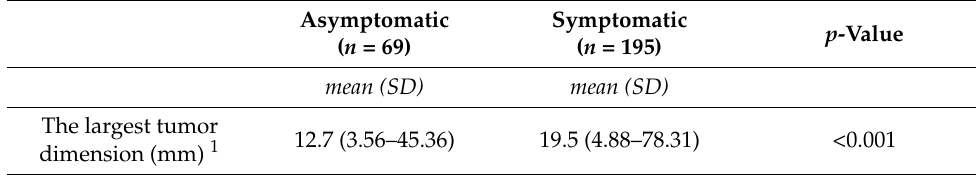
Table 2. Tumor ultrasound